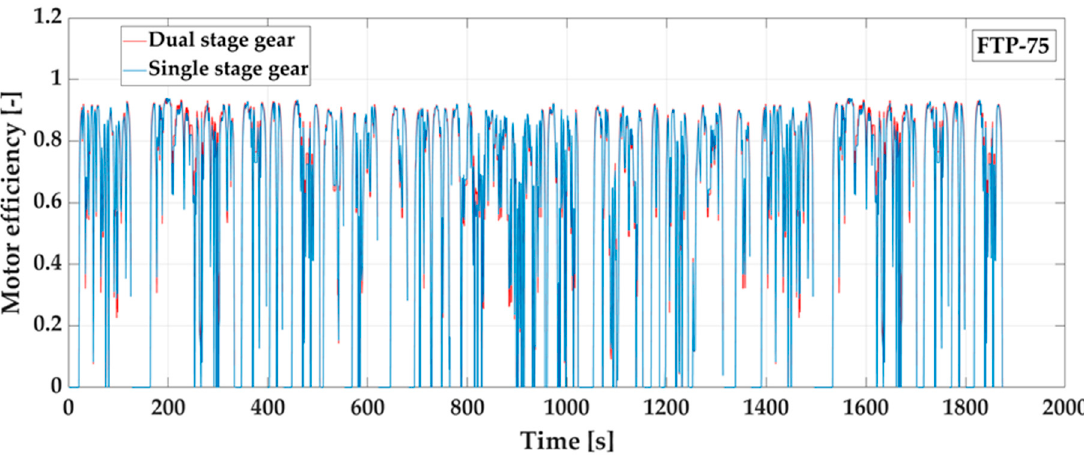
Figure 12. Motor efficiency vs. time for FTP-75.